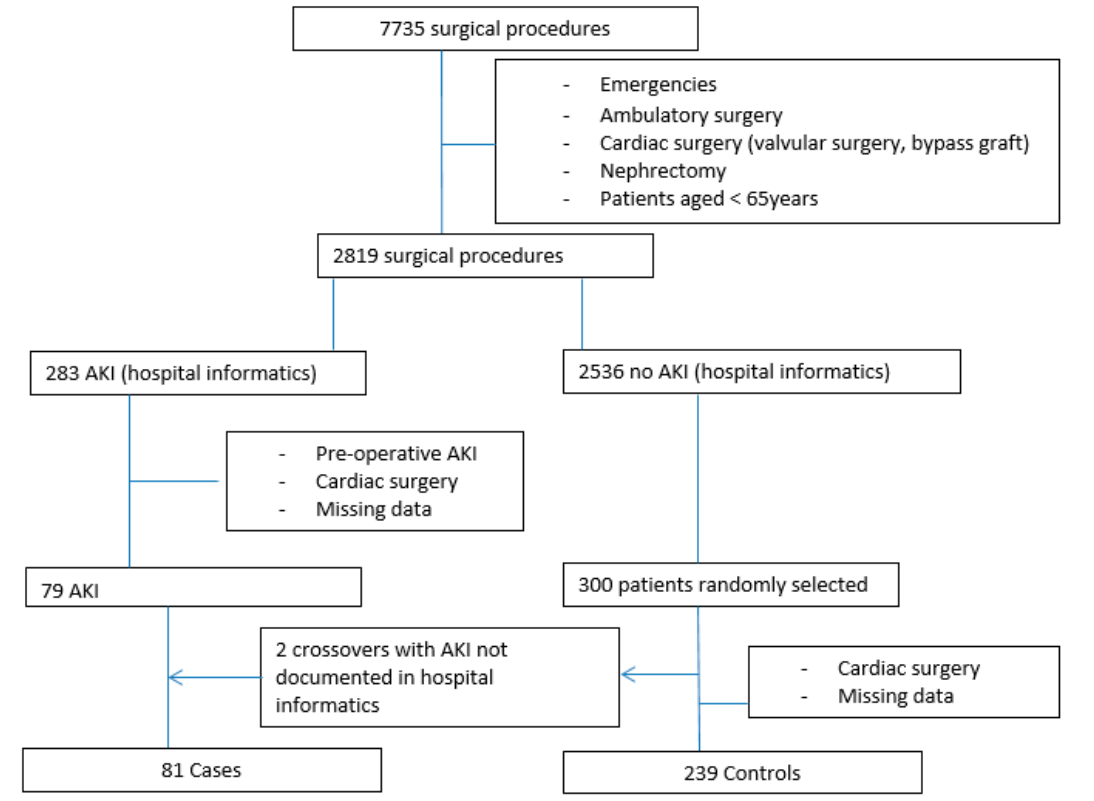
Figure 1. Flow chart of the study population that had acute kidney injury (AKI).